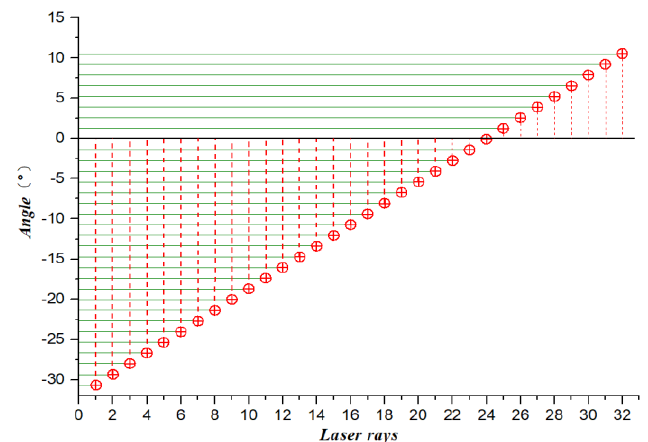
Figure 3. Schematic of 3D LIDAR scan lines